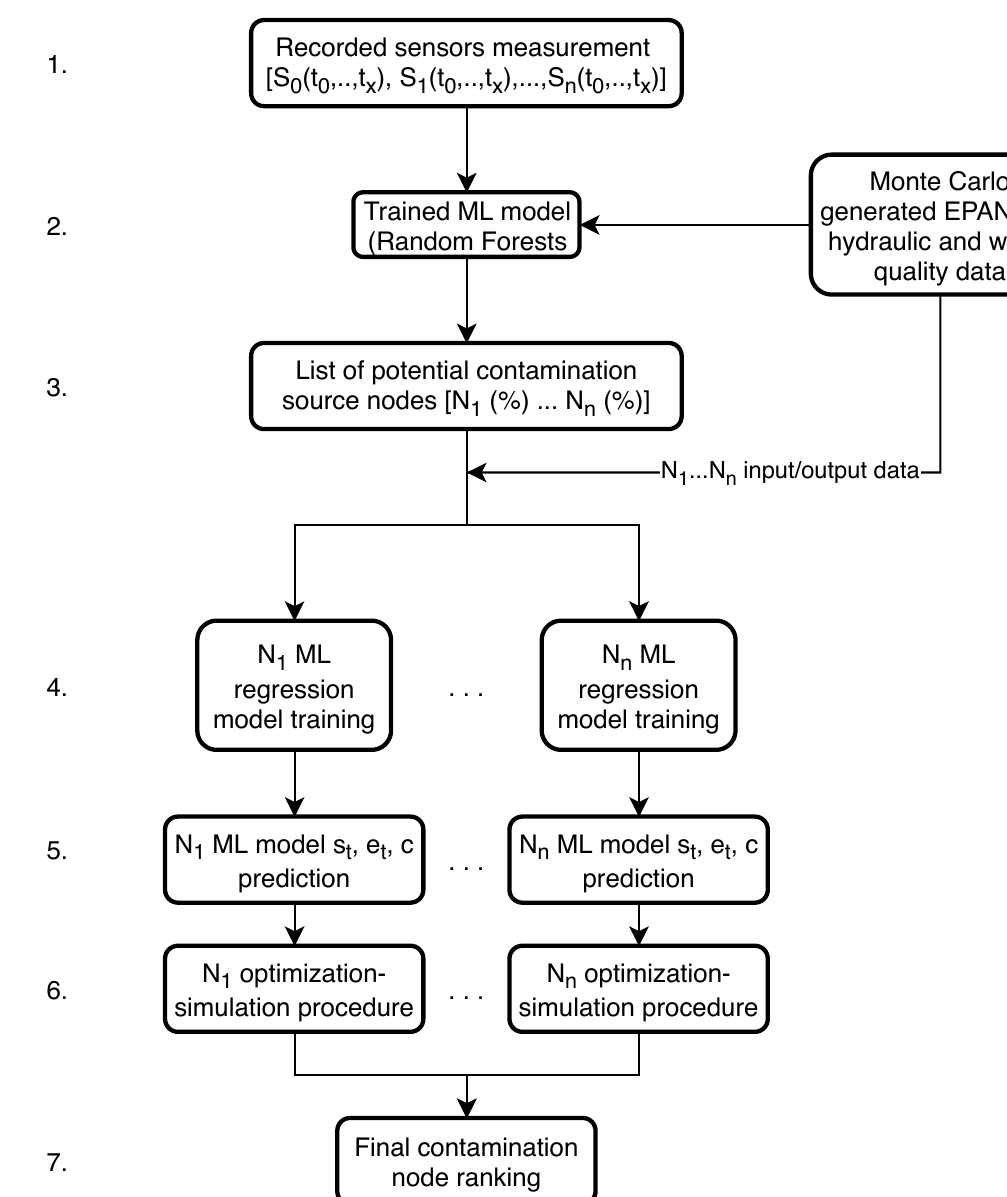
Figure 6. Machine learning and simulation-optimization coupling algorithmic framework 2 flowchart. Step 4. of the algorithmic framework is to separately train ML regression models for each predicted potential contamination source node (from steps 1.–3.) using pre-generated Monte Carlo data (EPANET2 hydraulic and water quality analysis) which was also used for the ML model classifier training (step 2.). This step is done in parallel where each node’s ML regression model is trained on a separate CPU. The input data of each node’s ML regression model training were the water supply network sensor measurements and the outputs were the corresponding values of s t , e t and c . After each node’s ML regression models were trained, the recorded sensor measurements (from step 1.) were then used for prediction of s t , e t and c (step 5.). Steps 4. and 5. of the algorithmic framework can be observed in Figure 7 with more